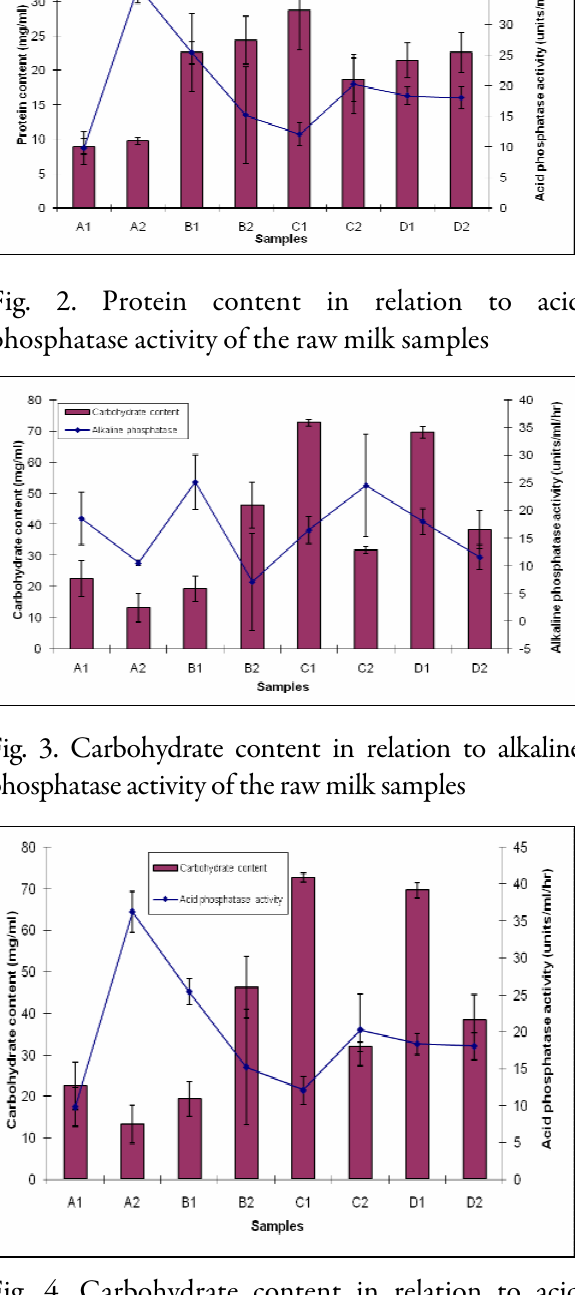
Fig. 4. Carbohydrate content in relation to acid phosphatase activity in the raw milk samples